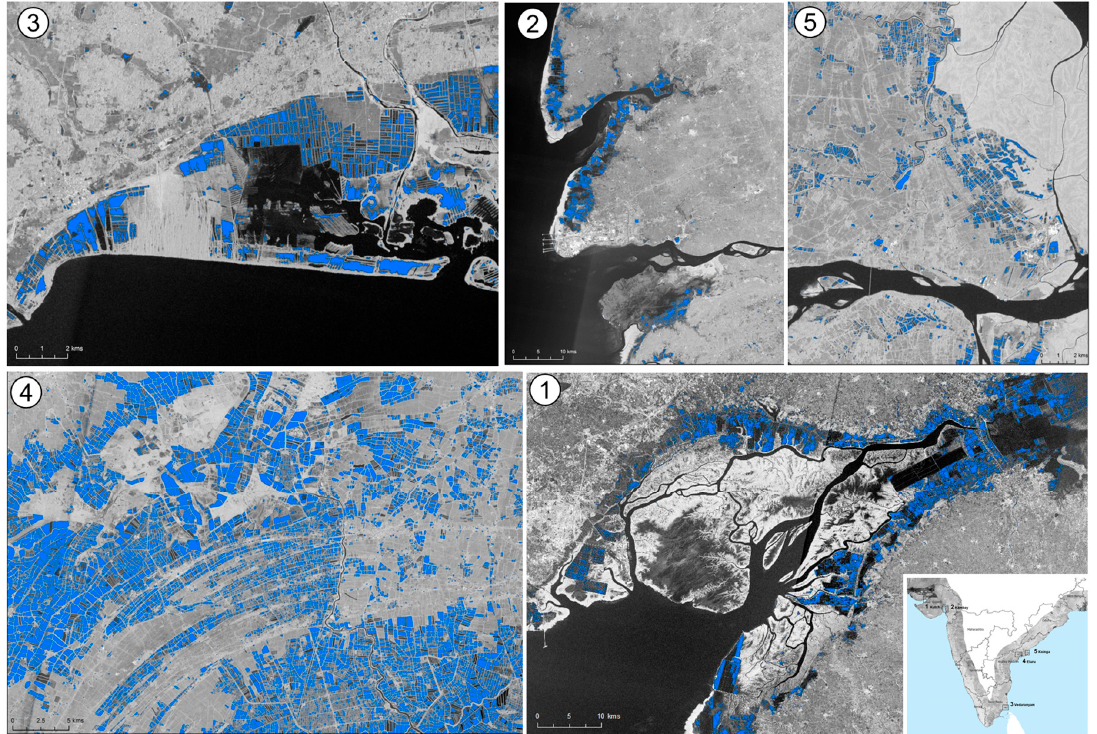
Figure 5. Temporal median backscatter images derived from the Sentinel-1 interferometric wide-swath (IW) ground range detected high-resolution (GRDH) data overlaid with extracted aquaculture, using the connected component segmentation method; (1) Kutch, Gujarat; (2) Kambay, Gujarat; (3) Vedaranyam, Tamil Nadu; (4) Eluru, Andhra Pradesh; (5) Gangetic Delta, West Bengal.